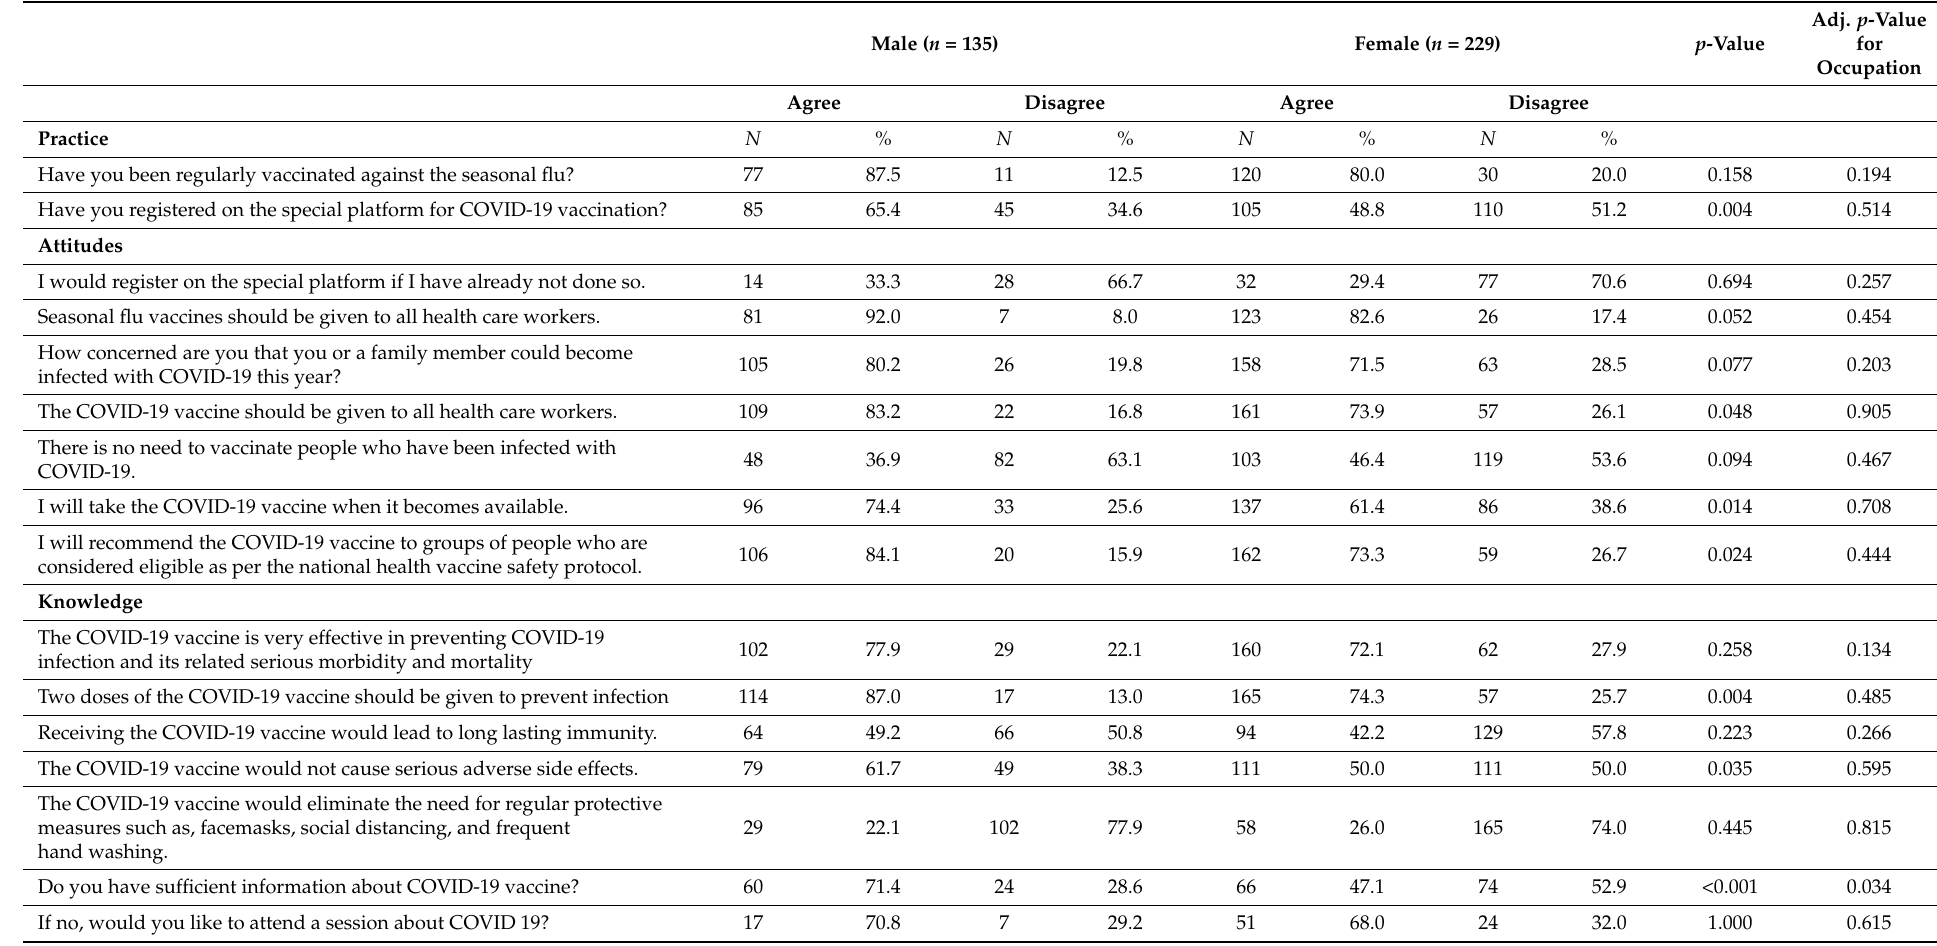
Table 3. Participants’ responses stratified by